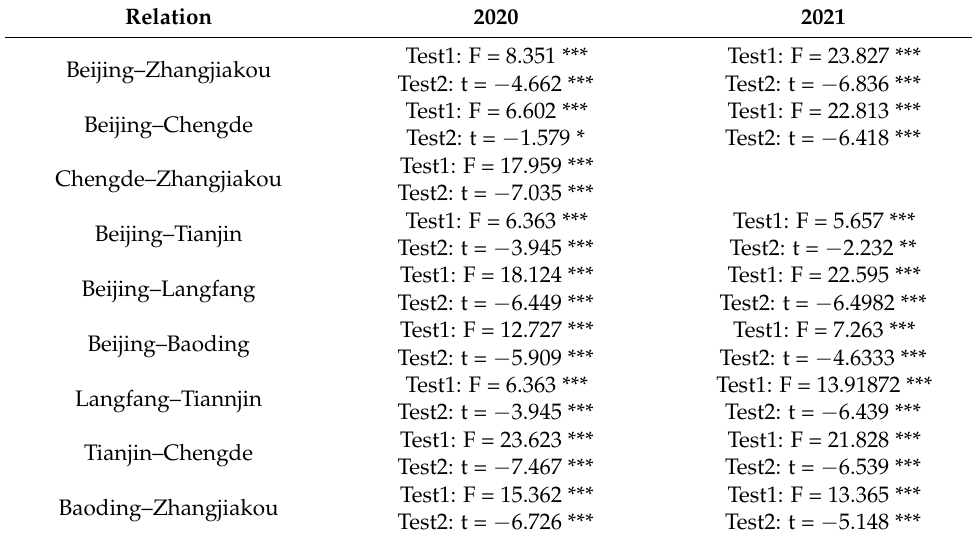
Table 1. Cointegration test on the COVID-19 epidemic and the distance between phase differences.